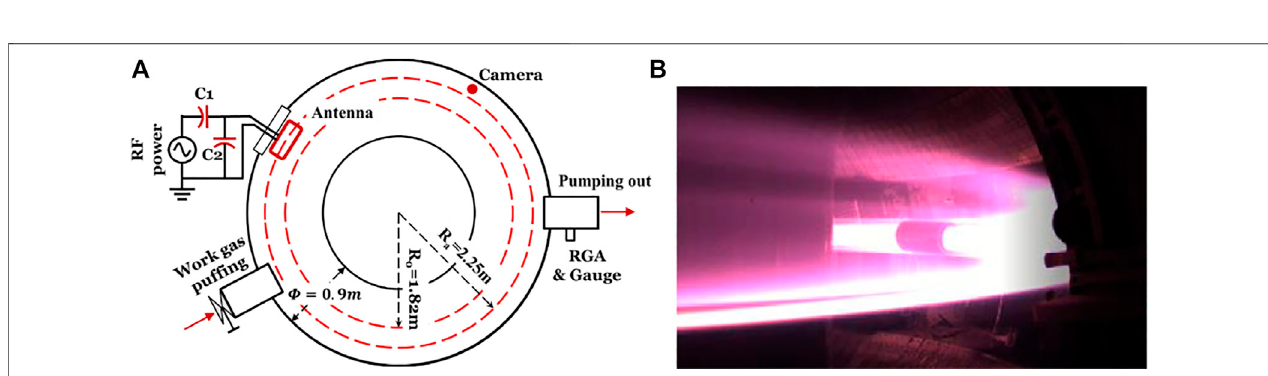
FIGURE 11 | Wall conditioning on EAST via helicon discharge: (A) experimental setup, (B) typical image. Reproduced from [68], with the permission of IEEE Publishing.